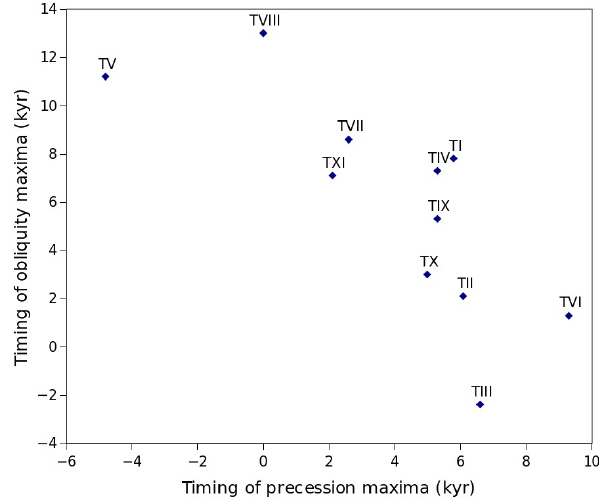
Fig. 3. Timing of precession and obliquity maxima at deglaciation triggers. A positive number means that the maximum occurs after the